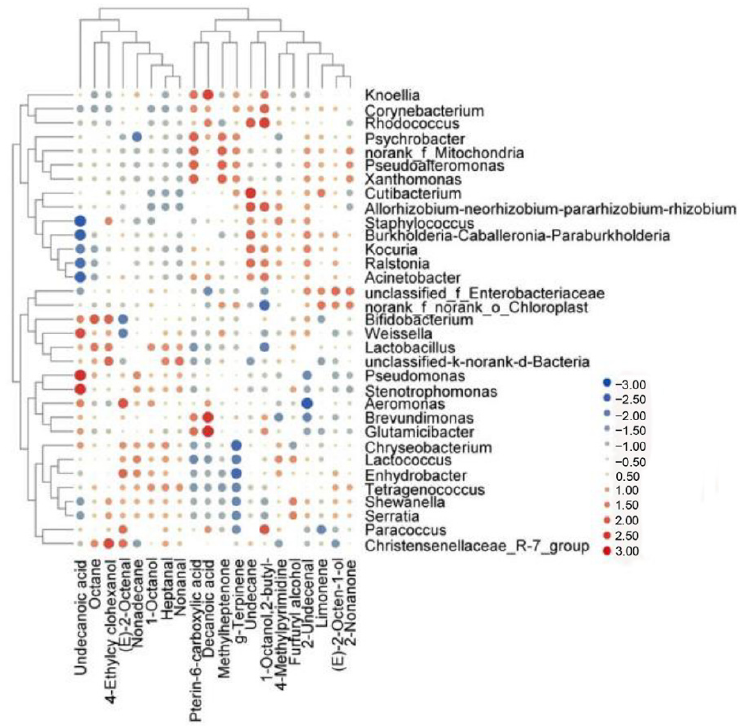
Figure 6. Heat map of the correlation between flavor compounds and microorganisms of beef jerky.